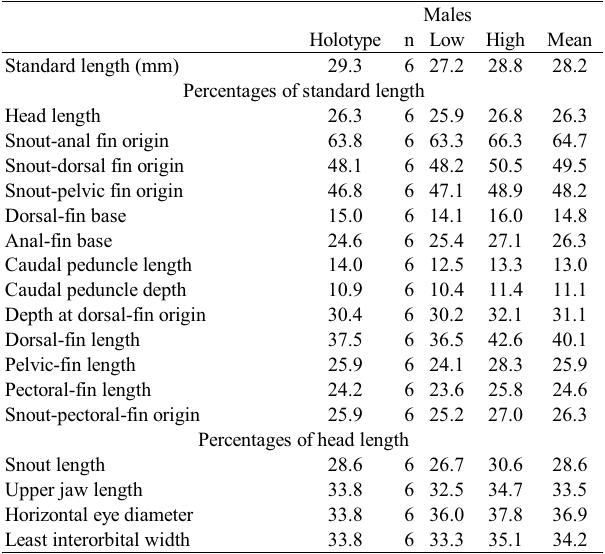
Table 3. Morphometrics of Odontostilbe pao (holotype MCNG 54497, and paratypes MCNG